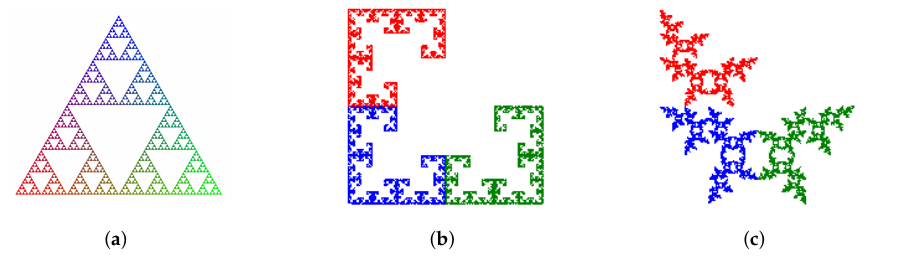
Figure 2. ( a ) Sierpinski gasket, ( b ) and ( c ) two members from its family.